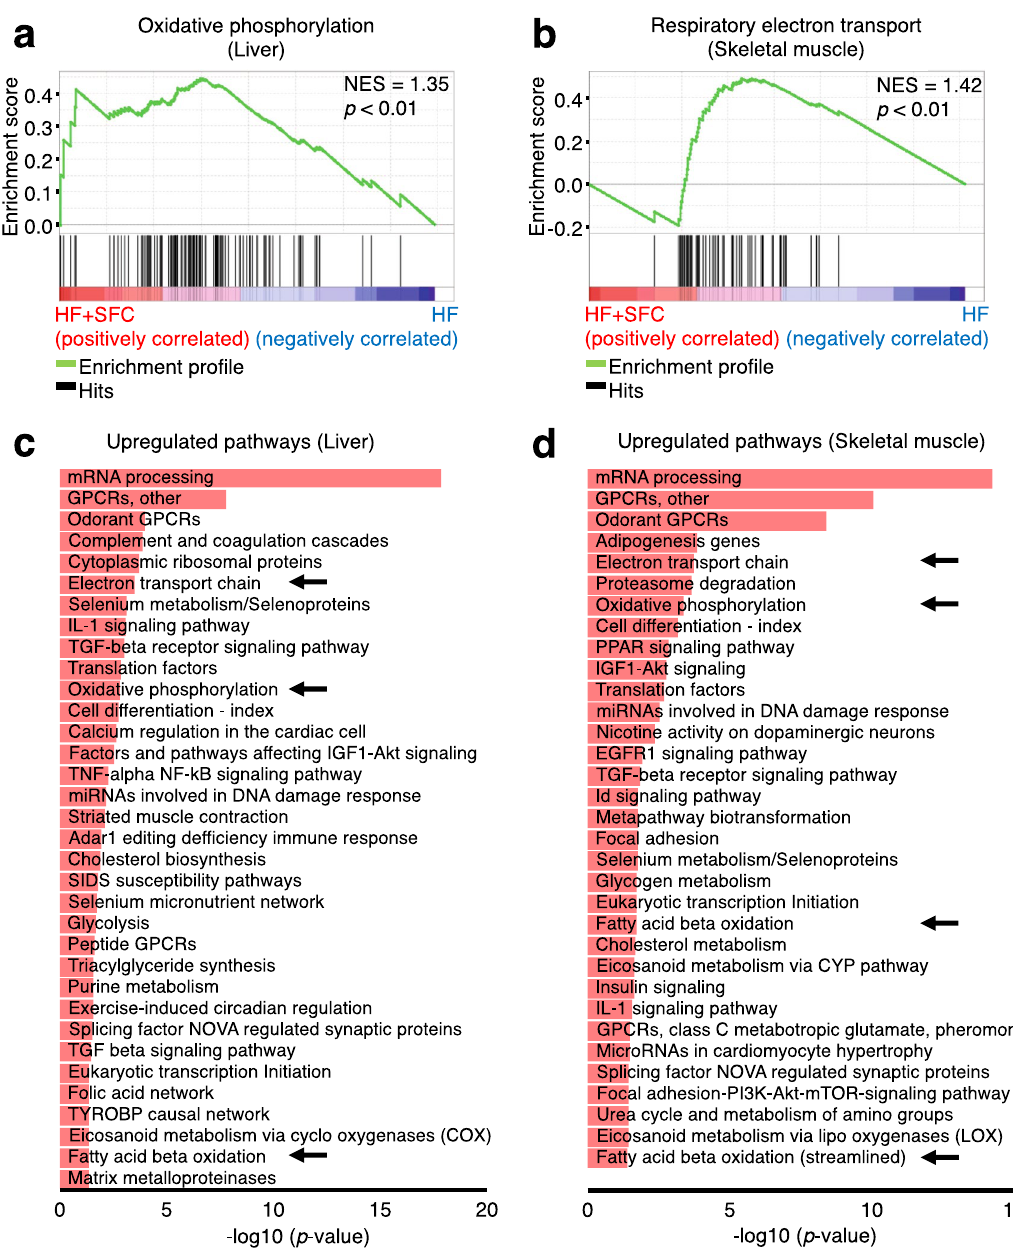
Figure 4. Microarray analysis shows iron supplementation improves transcription of energy metabolism and mitochondrial related genes in the liver and skeletal muscle. ( a – h ) Male C57BL/6J mice of 6 weeks of age were fed with each diet for 15 weeks as specified in Fig. 1. For each group, a mix of all sample cDNAs was used. ( a , b ) Enrichment plots of genes upregulated in HF + SFC ( a ) liver; and ( b ) skeletal muscle (compared to HF). ( a ) The Kyoto Encyclopedia of Genes and Genomes (KEGG) database; or ( b ) Reactome database was used. The analysis was performed by Gene Set Enrichment Analysis (GSEA). NES normalized enrichment score. ( c , d ) Pathways containing upregulated genes by greater than or equal to 1.5-fold in HF + SFC ( c ) liver; and ( d ) skeletal muscle (compared to HF) ( p < 0.05). WikiPathways database was used. The analysis was performed by Transcriptome Analysis Console (TAC). ( e , g ) Pathway mapping for electron transport chain (ETC) in ( e ) liver; and ( g ) skeletal muscle. Upregulated genes in HF + SFC are shown as red gradations (compared to HF). The analysis was performed by TAC. The pathway mapping was created on the basis of the Wikipathways database (https:// www. wikip athwa ys. org/ index. php/ Pathw ay: WP295). ( f , h ) Venn diagrams representing the number of differentially expressed mitochondrial genes (greater than or equal to 1.5-fold) in ( f ) liver; and ( h ) skeletal muscle. Mitochondrial genes were based on the MitoCarta2.0